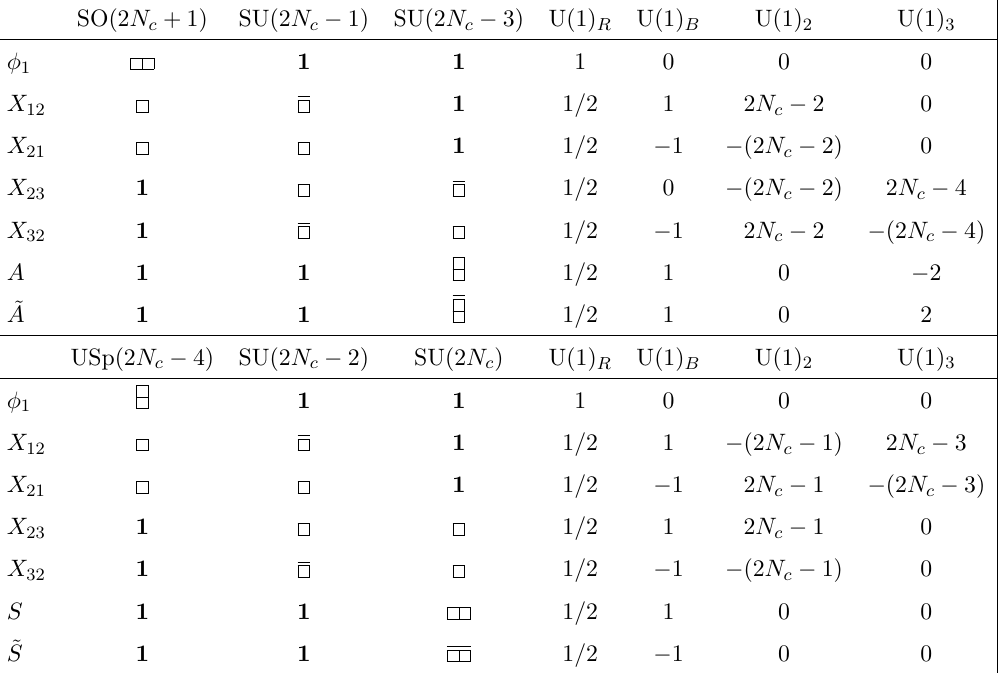
Table 8 . Matter content and charges of N = 1 S-dual quivers with n g = 2